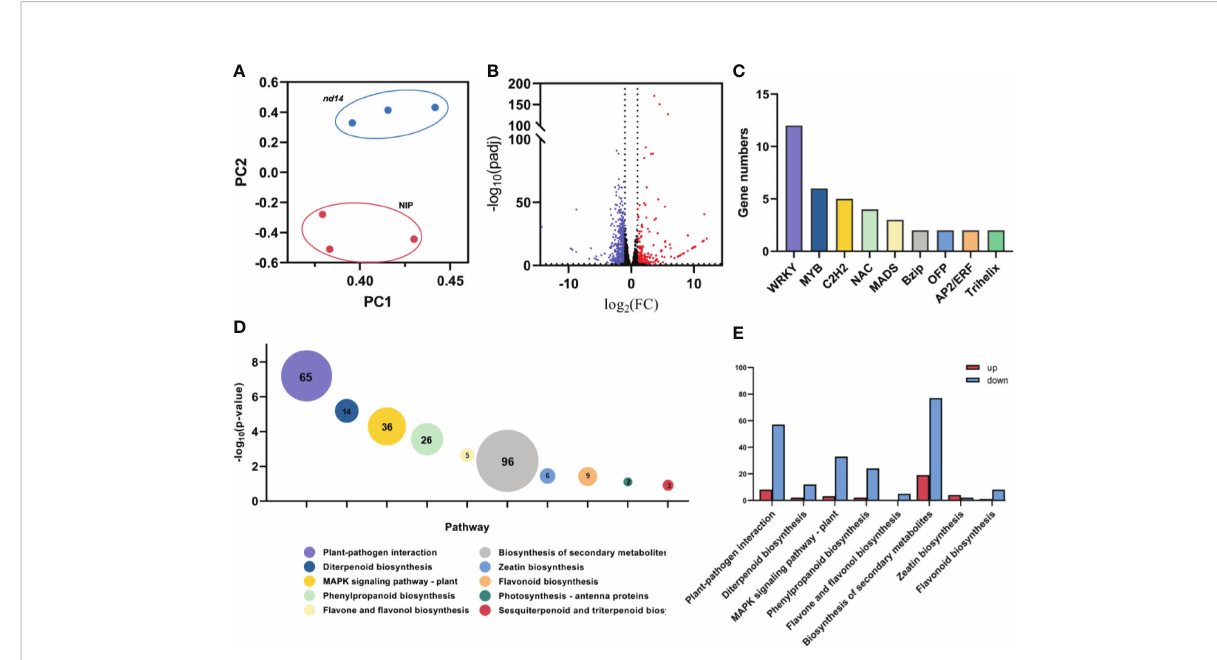
FIGURE 5 Transcriptome analysis of the wild-type and nudx14 plants. (A) Principal component analysis (PCA) of transcriptomes in different samples. (B) Volcano plot of DEGs (259 upregulated and 759 downregulated genes) in WT and nudx14 plants. (C) Number of DEGs related to transcription factors. (D) Top 10 pathway enrichments of DEGs analyzed by Kyoto encyclopedia of genes and genomes, bubble size and data labels indicate gene numbers. (E) the number of upregulated and downregulated DEGs related to top 10 pathway